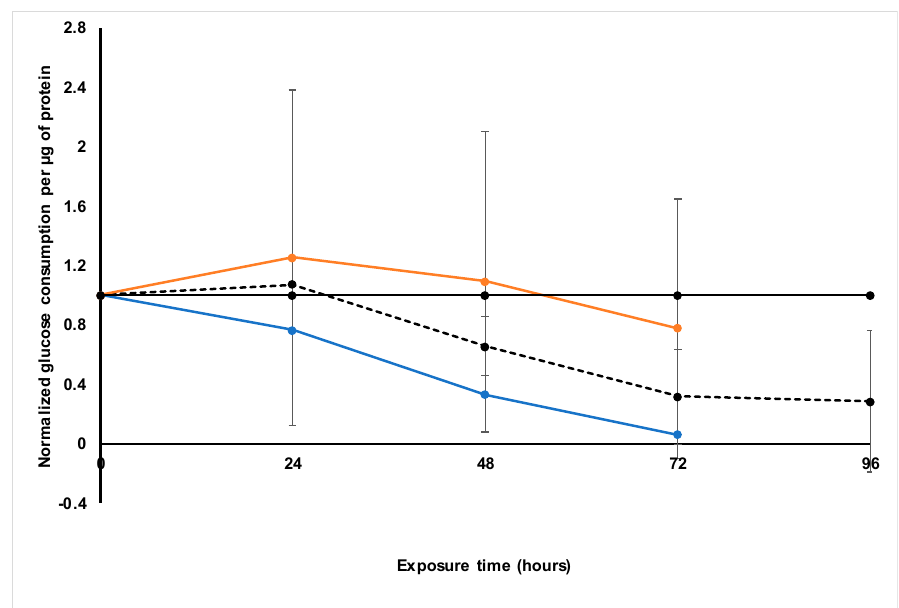
Figure 5. Normalized glucose consumption per microgram protein following exposure of the sodium alginate encapsulated LS180 mini-tumor model to Sutherlandia frutescens aqueous extract and paclitaxel. The solid black line represents the untreated control, the black dashed line represents paclitaxel [IC 50 ], the orange line represents S. frutescens [IC 50 ] and the blue line S. frutescens [IC 50 ]/2. All data were normalized to the untreated control group (error bars = standard deviation; n = 3 for S. frutescens [IC 50 ]/2; n = 6 for S. frutescens [IC 50 ] and paclitaxel [IC 50 ]. There was a clear and significant decrease in the levels of glucose consumed from 48 h onwards, following treatment with paclitaxel, relative to the untreated control group. From 72 h, very little glucose appeared to be consumed by the paclitaxel-treated LS180 spheroids